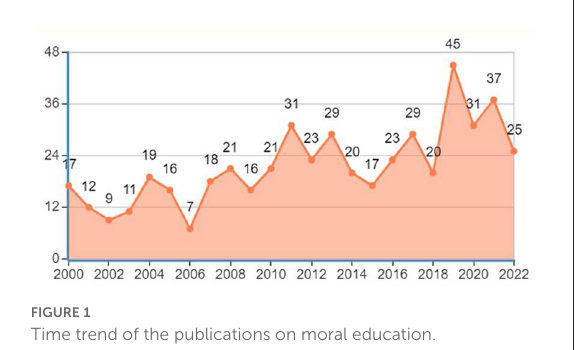
FIGURE1 Time trend of the publications on moral